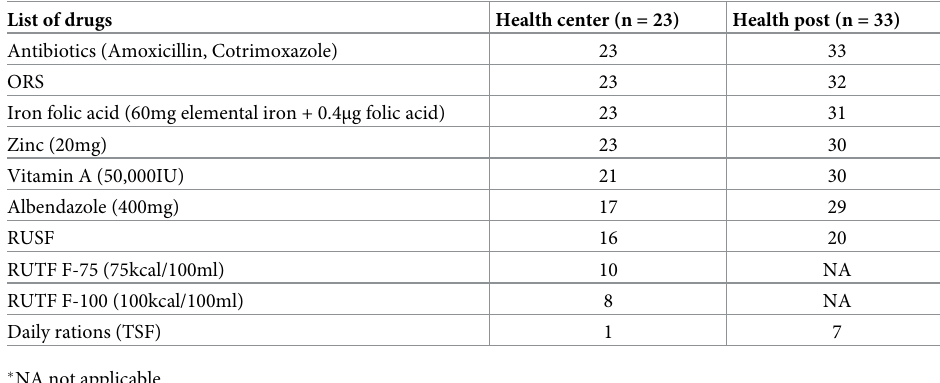
Table 3. Availability of drug supply for nutrition services at health centers and health posts. List of